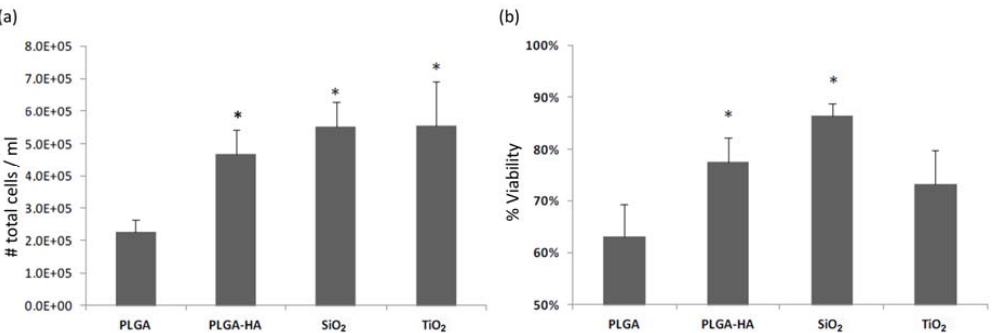
Figure 2. ( a ) Number of total cells adhered to the membranes. ( b ) percentage of viability of cells. * p < 0.05, statistically significant differences with respect to PLGA control membrane.